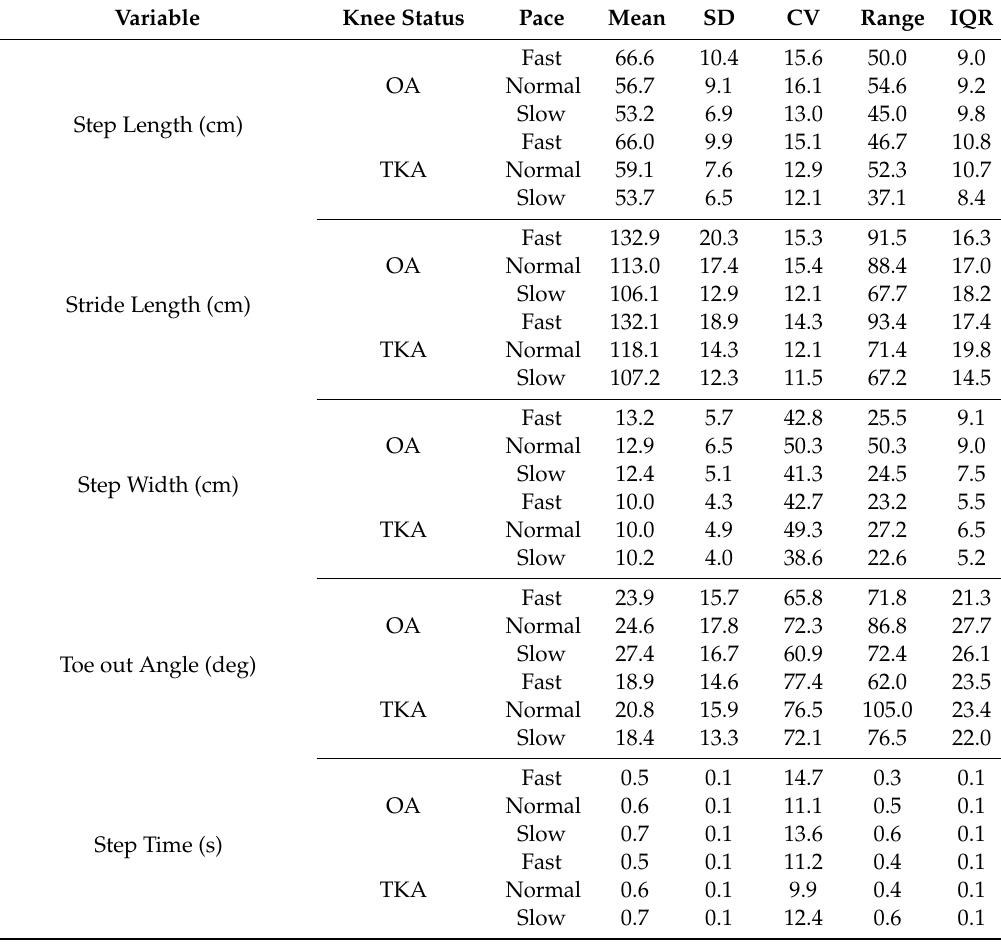
Table 3. Descriptive statistic of spatial, temporal, and general parameters of dataset grouped by knee and pace (SD: Standard Deviation, CV: Coe ffi cient of Variation, IQR: Interquartile Range).